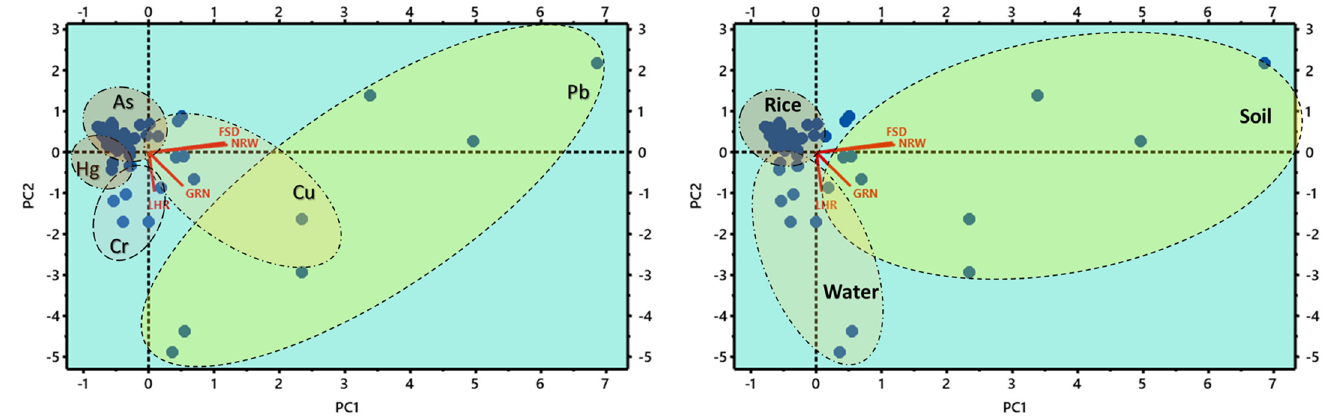
Figure 6. Principal component analysis (PCA) graph showing variables of metal and metalloid concentrations and clusters based on the similarity in chemical characteristics of sampling locations in the study area. It seems that Cu, Pb, and As originated from the same source and show similarities in chemical behaviors and enrichment. The possible sources of these metals and metalloids might be anthropogenic activities and contaminated irrigation water. It is interesting to note that a large number of sampled sites are clustered together in the quadrant of negative portions of PC1 and PC2.